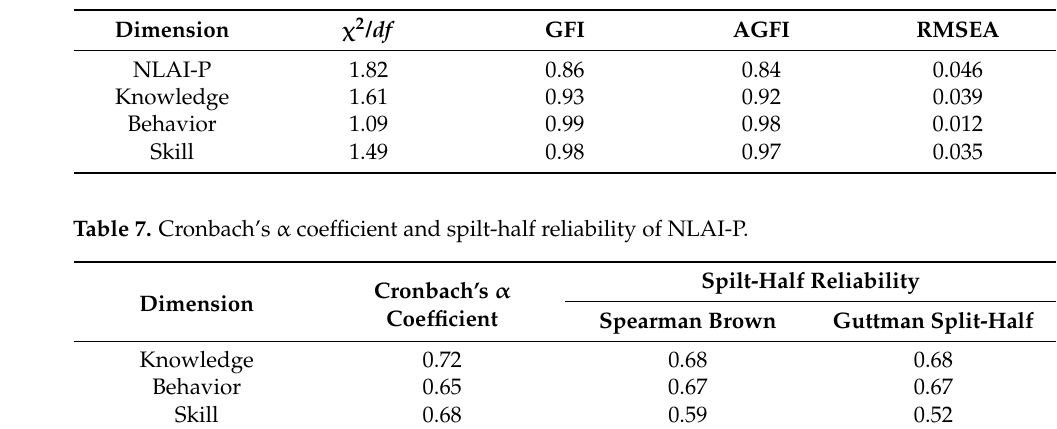
Table 6. Confirmatory factor analysis of NLAI-P.